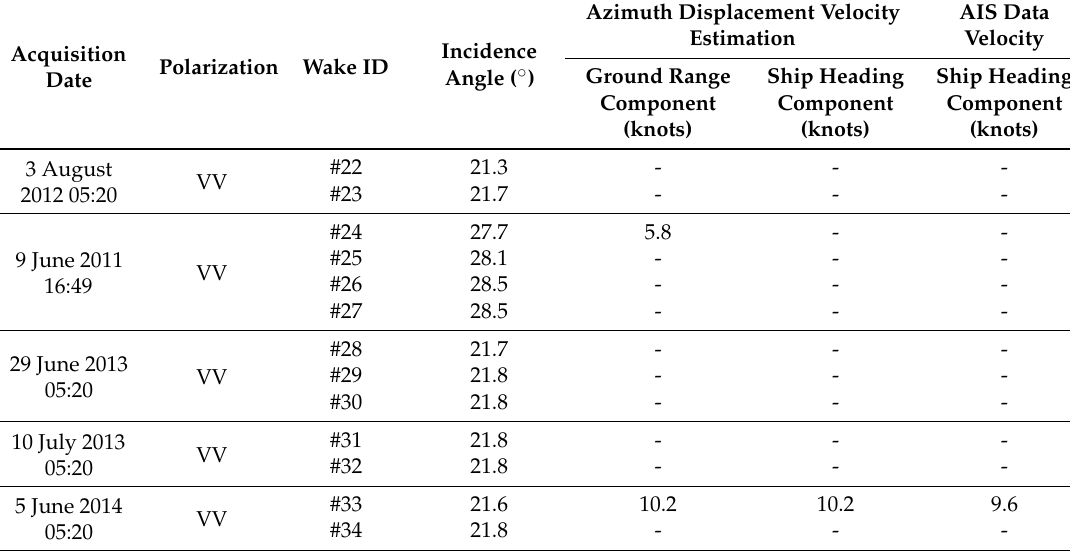
Table 4. TerraSAR-X dataset, imaged wakes and velocity estimation